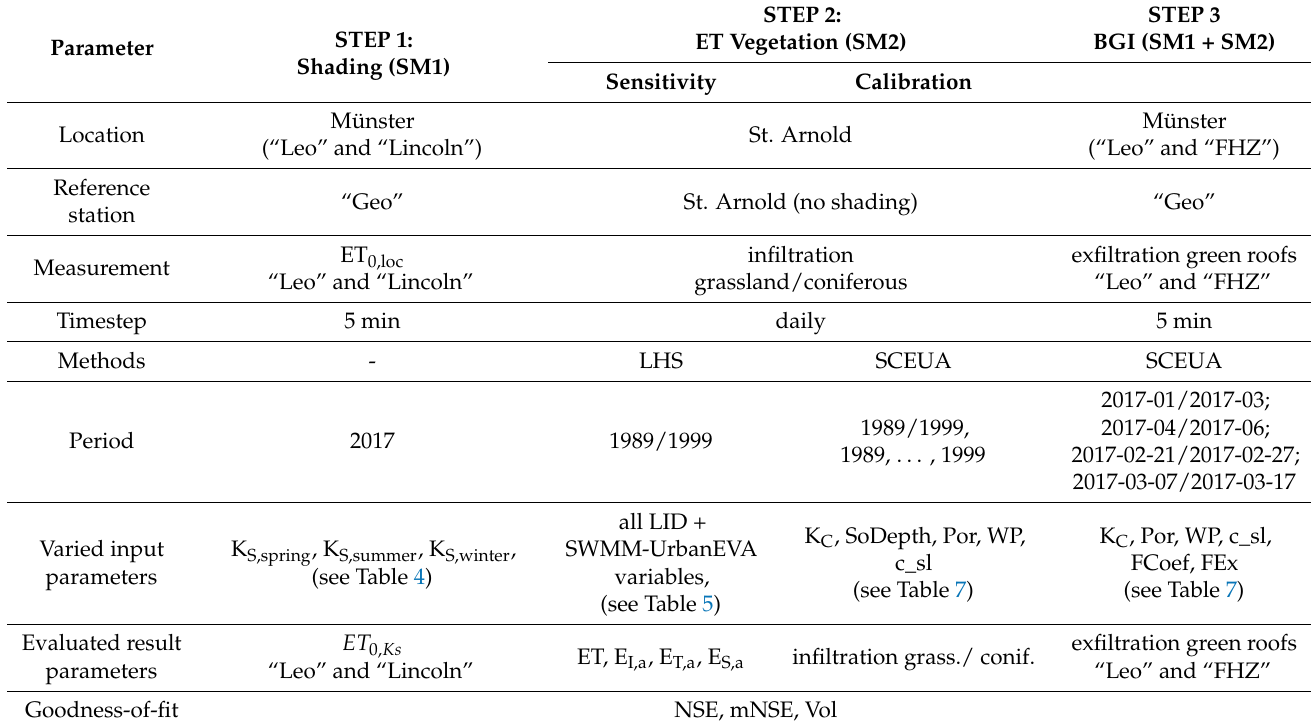
Table 2. Overview study set